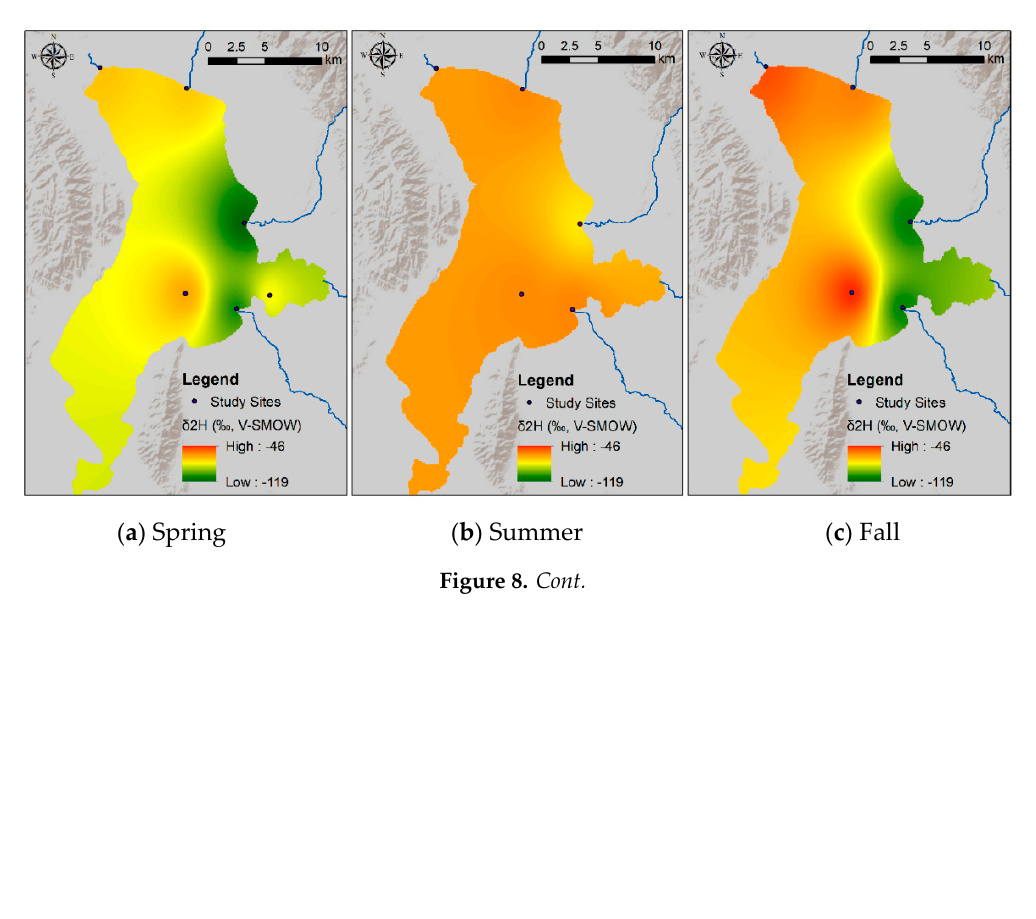
Figure 7. Plots of δ 2 H (blue circles) and δ 18 O (green triangles) values vs. depth for Utah Lake water samples collected in the spring ( a ), summer ( b ), and fall ( c ) 2015. Error bars correspond to ± 1 sd. The δ -values show no significant variability with depth, suggesting that the lake is well-mixed vertically.